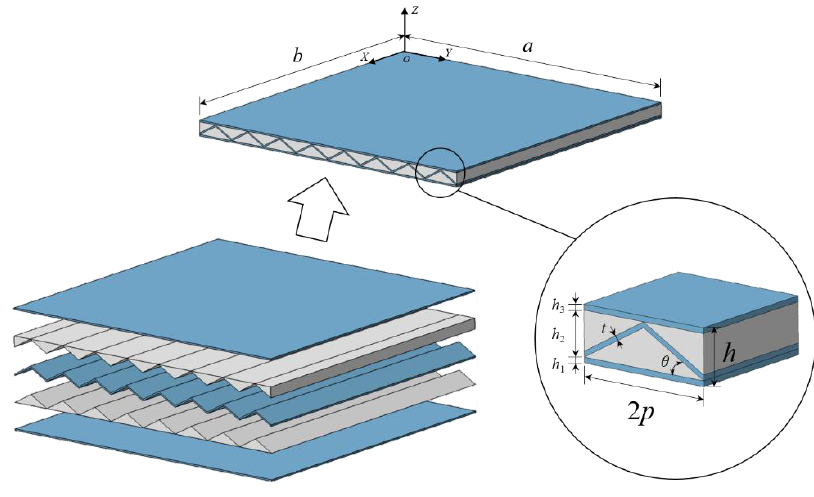
Figure 1. A typical hybrid corrugated sandwich plate with its composition.